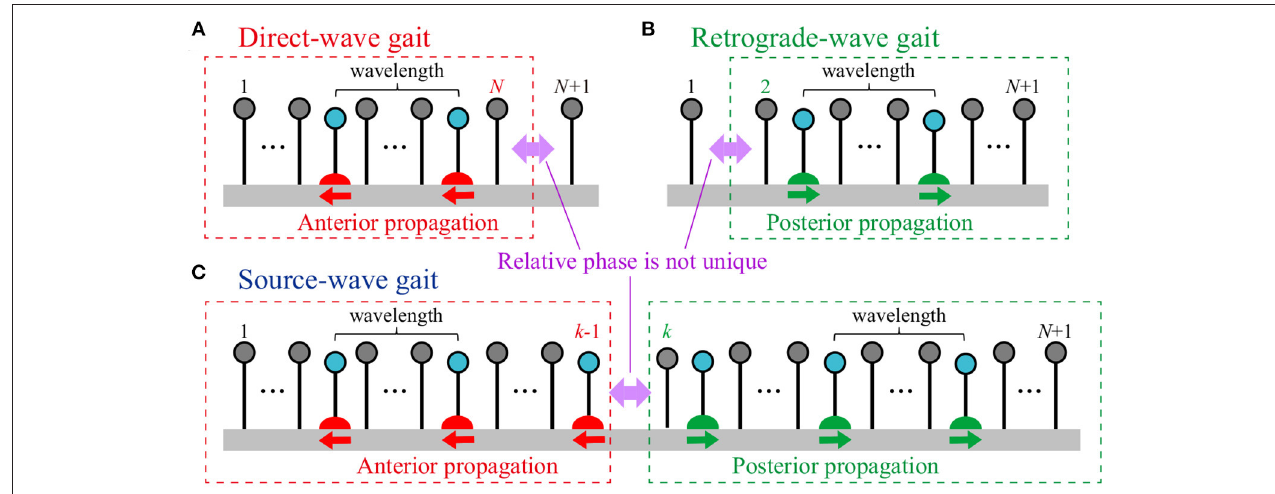
FIGURE 7 | Three types of gaits for N 1 mass points: (A) Direct-wave, (B) retrograde-wave, and (C) source-wave gaits. In the direct-wave (retrograde-wave) gait, + while the swing leg movements of Legs 1 to N (Legs 2 to N 1) propagate anteriorly (posteriorly) with a constant relative phase, the relative phase between Legs N + and N 1 (Legs 1 and 2) is not unique. In the source-wave gait, while the swing leg movements of the anterior part (Legs 1 to k + those of the posterior part (Legs k to N